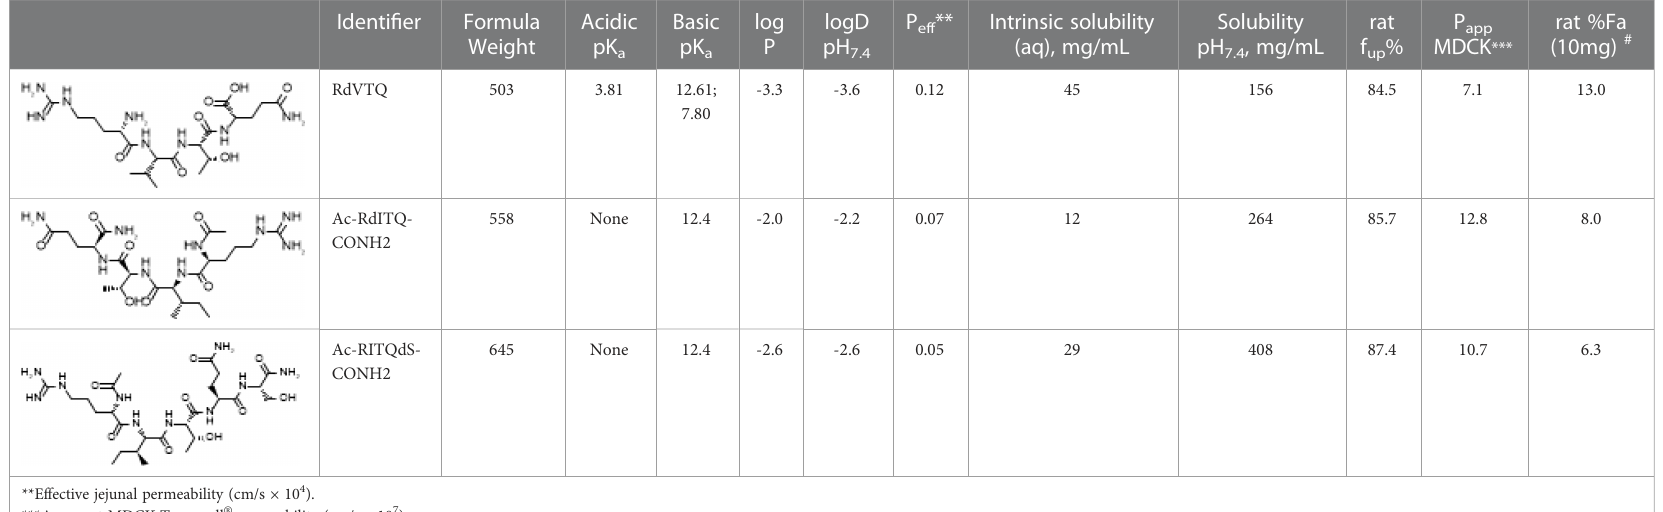
TABLE 1 Calculated physicochemical and biopharmaceutical properties of peptides tested in vivo rat pharmacokinetic